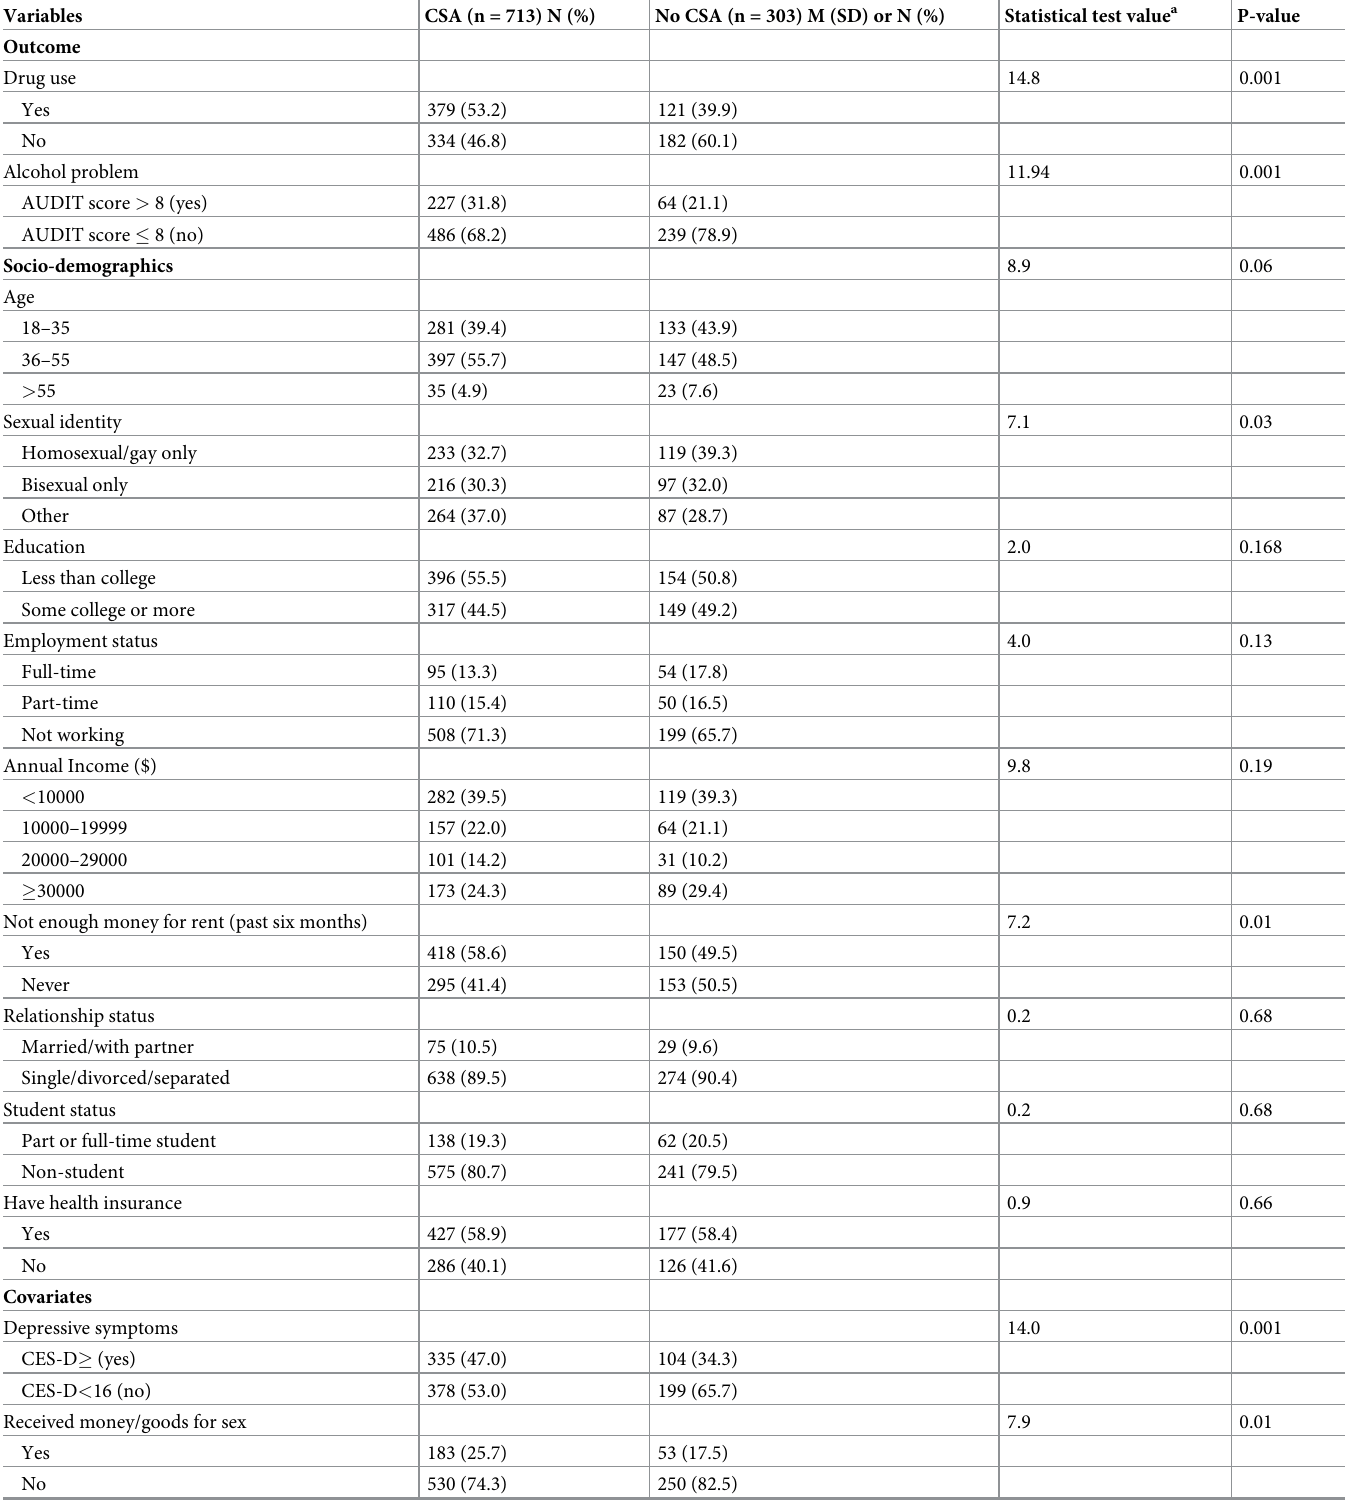
Table 2. Descriptive summary of study variables by childhood sexual abuse (N =